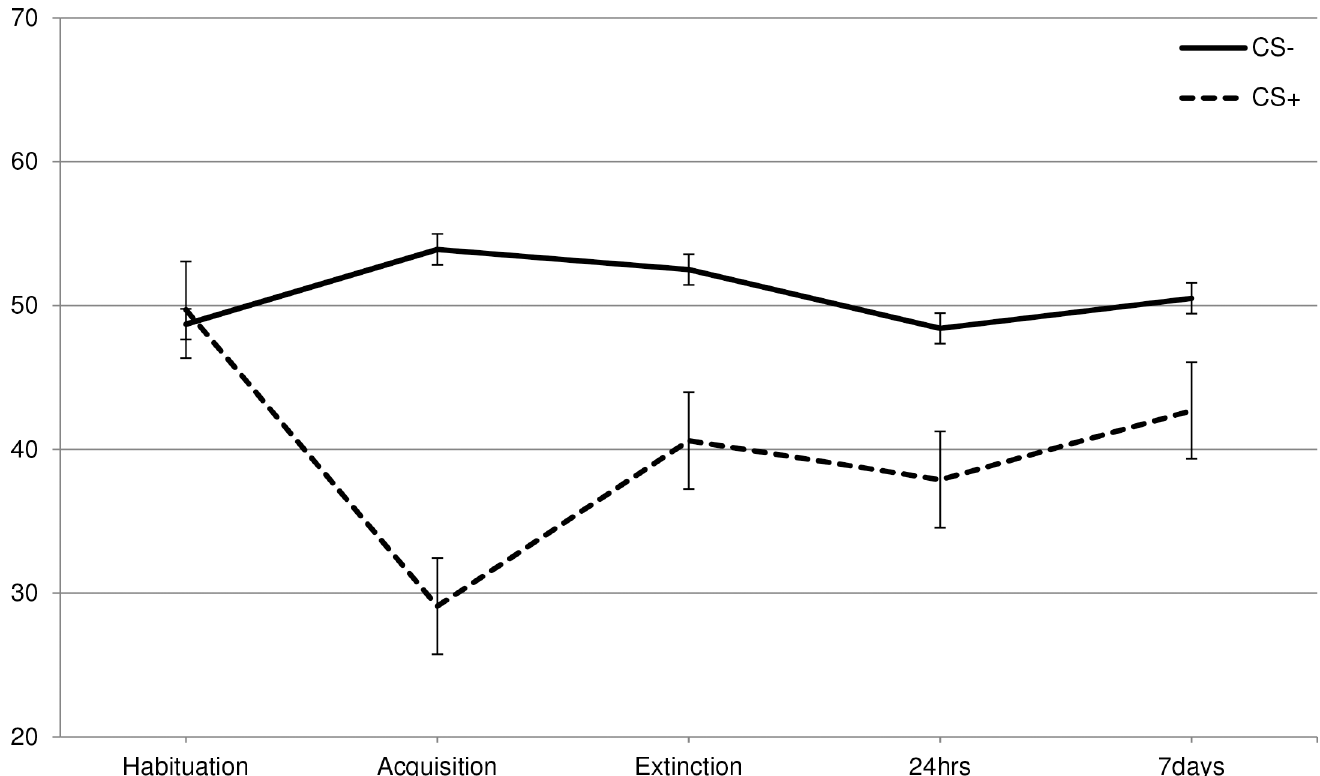
Fig 3. Self-reported valence. Total scores in the different phases (habituation, acquisition, extinction, 24hrs and 7 days) of the self-reported